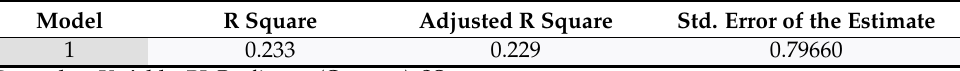
Table 4. Model summary.